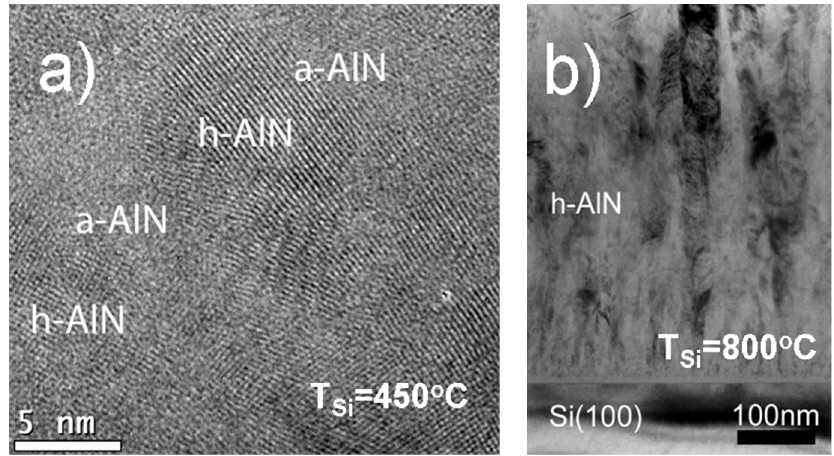
Figure 5. HR-TEM image of nano-sized crystalline grains in amorphous matrix ( a ) and bright field cross-sectional TEM image ( b ) of the PLD AlN films deposited at 450 and 800 °C, respectively. The other PLD parameters were identical: N 2 pressure of 0.1 Pa, LPF of 40 Hz, and laser fluence of ≈ 3 J/cm 2 .